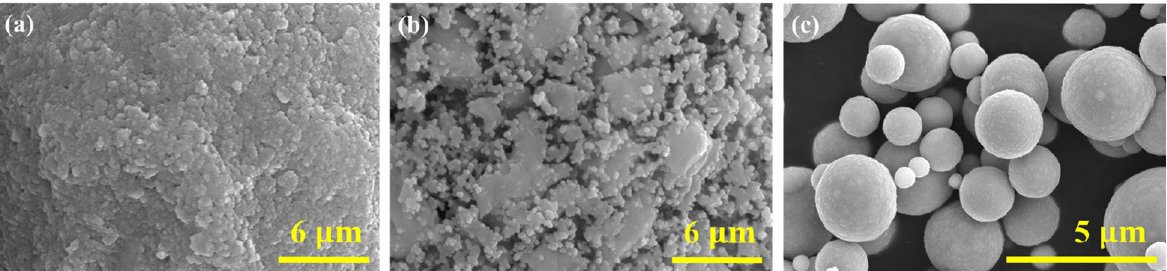
Figure 2. Scanning electron microscopy images of ( a ) iron oxide nanopowder, ( b ) hydrogen-reduced iron nanopowder agglomerates showing bimodal particle size distributions, and ( c ) spherical Fe